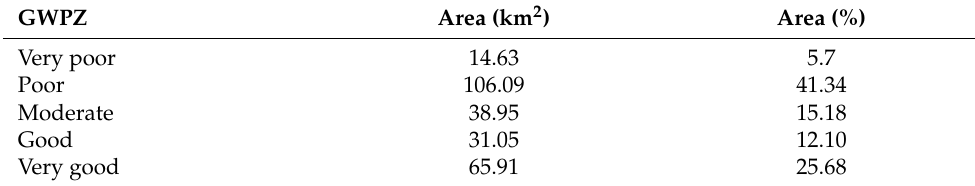
Table 9. GWPZ classes in the Titel